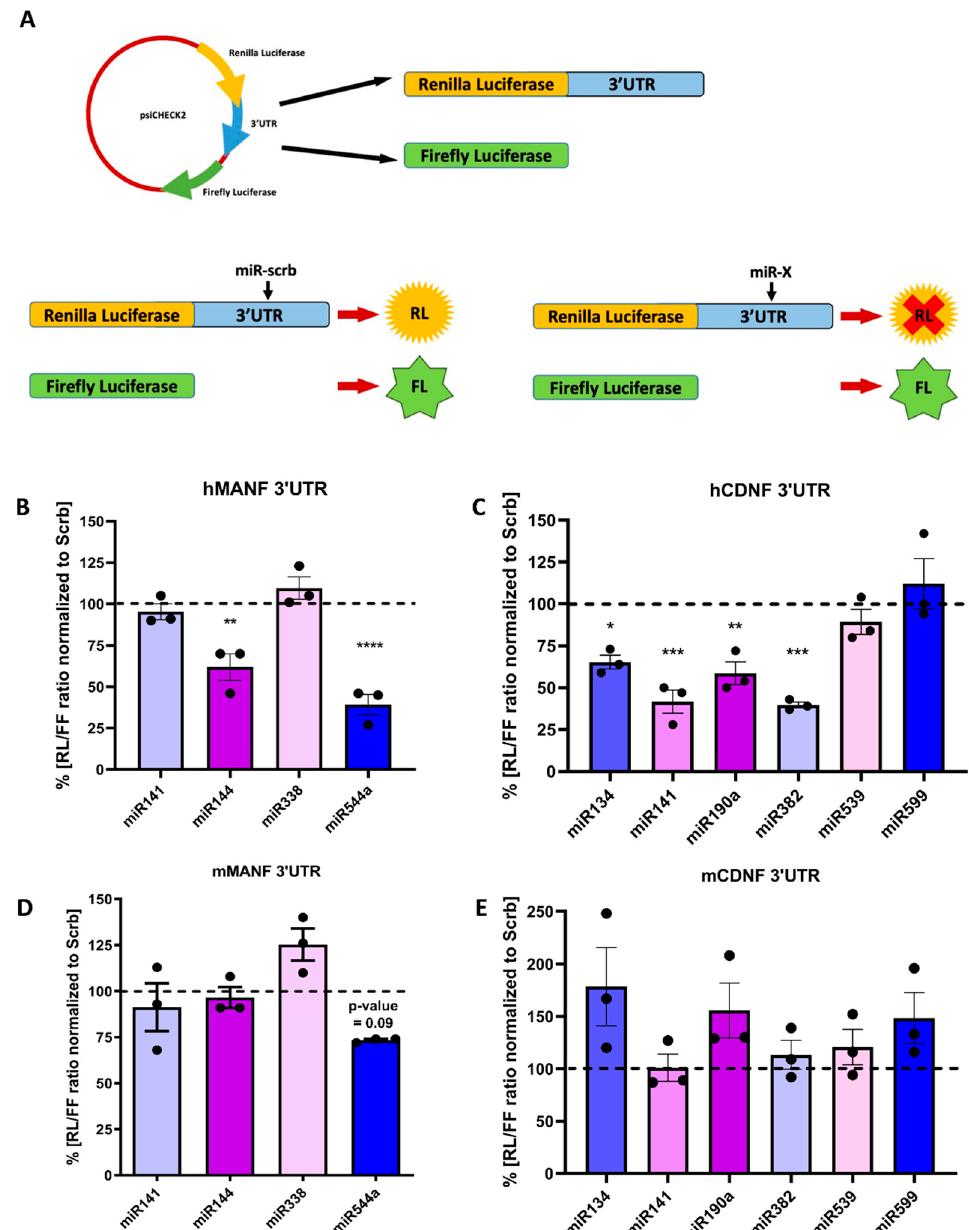
Figure 3. ( A ) Dual-luciferase reporter assay scheme: expression of Renilla luciferase is controlled by 3 ′ UTR of gene of interest, while Firefly luciferase expression is independent and used as transfection efficiency control. Luciferase activity of reporter constructs, containing 3 (cid:48) UTRs of ( B ) human MANF, ( C ) human CDNF, ( D ) mouse MANF and ( E ) mouse CDNF, co-transfected with miRNA mimics. Each dot represents mean value from one independent experimental plate